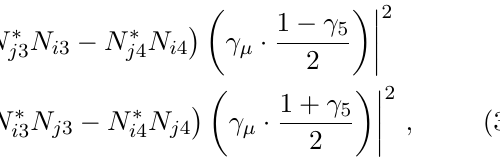
and (b) S e(cid:11) 1